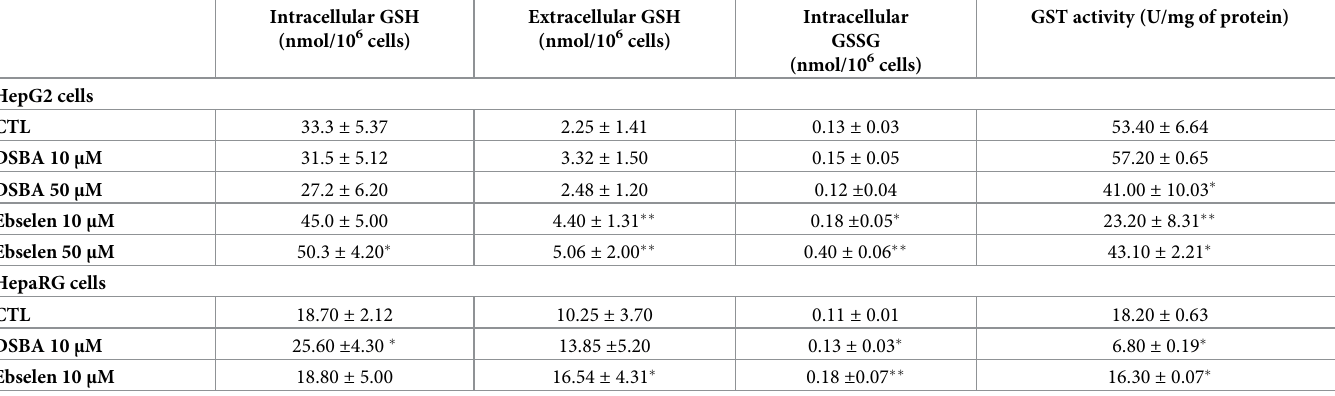
t-test: CTL (vehicle = DMSO) vs treatment � p < 0.05 �� p <